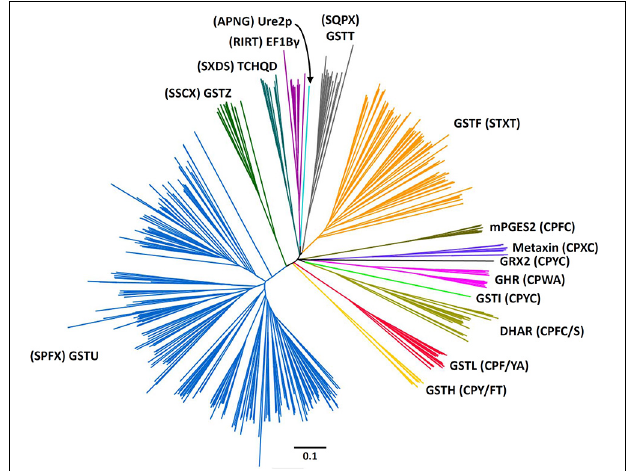
FIGURE 1 | Rooted phylogenetic tree of plant GSTs. The sequences used are those identified in Arabidopsis thaliana (Lan et al., 2009), Hordeum vulgare (Rezaei et al., 2013), Oryza sativa (Lan et al., 2009), Physcomitrella patens (Liu et al., 2013), Pinus tabulaeformis (Lan et al., 2013), Populus trichocarpa (Lan et al., 2009), and Solanum lycopersicum (Csiszar et al., 2014). Sequences were aligned with PROMALS3D and alignment manually adjusted with Seaview software (Gouy et al., 2010). The phylogenetic tree was constructed with BioNJ (Gascuel, 1997) in Seaview, rooted with E. coli glutaredoxin 2 and edited with Figtree software (http://tree . bio . ed . ac . uk/software/figtree/). The robustness of the branches was assessed by the bootstrap method with 500 replications. Various classes can be distinguished: Dehydroascorbate reductase (DHAR), Elongation factor 1B γ (EF1B γ ), Glutathionyl hydroquinone reductase (GHR), Phi (GSTF), Hemerythrin (GSTH), Iota (GSTI), Lambda (GSTL), Theta (GSTT), Tau (GSTU), Zeta (GSTZ), Microsomal prostaglandin E synthase type 2 (mPGES-2), Tetrachloro-hydroquinone dehalogenase (TCHQD), and Ure2p. The scale marker represents 0.1 substitutions per residue. For clarity, the names of the sequences have not been indicated but all sequences are available in the Supplementary